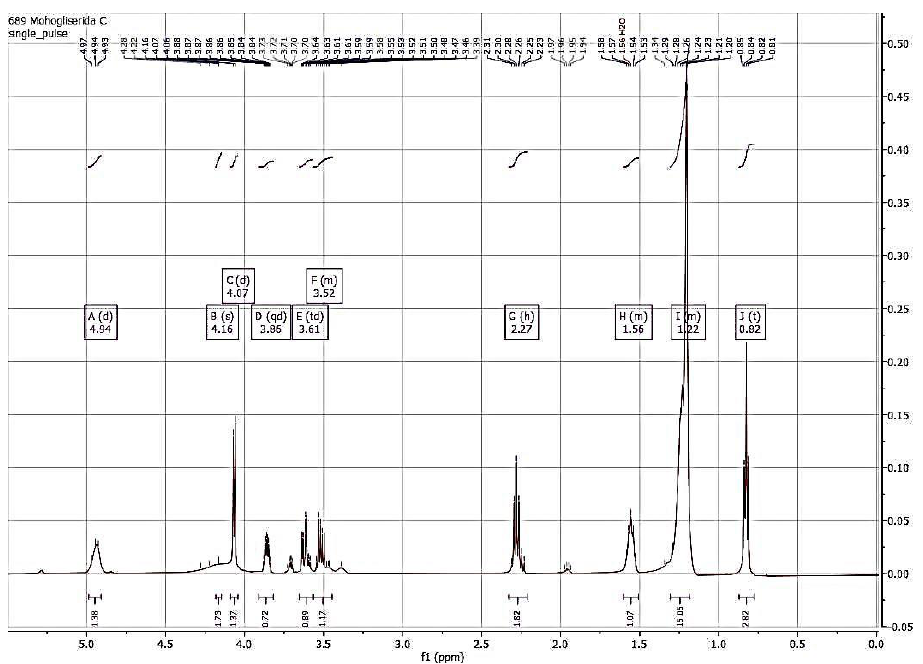
Figure 4. Spectrum 13 C NMR of monolaurin from glycerolysis reaction of PKOo-PKS blend with a ratio of 40:60 w/w for 24 h, at 40 °C, a molar ratio of oil to glycerol 1:4, solvent to oil ratio of 2:1 v/w , enzyme concentration of 10% w/w , and stirring speed 600 rpm. The NMR spectra showed the data spectrum of monolaurin as follows: 1 H-NMR (500 MHz, Cloroform-D) δ 4.94 (d, J = 8.7 Hz, 1H, OH), 4.16 (s, 2H, -(OH)CH-CH 2 -OCO-), 4.07 (d, J = 5.6 Hz, 1H, -CH 2 -(OH)CH-CH 2 -), 3.86 (qd, J = 5.8, 3.4 Hz, 1H, CH 2 - (OH)CH-CH 2 -), 3.61 (td, J = 10.8, 3.8 Hz, 1H, CH 2 - (OH)CH-CH 2 -), 3.56–3.45 (m, 1H, -CH 2 -(OH)CH-CH 2 -